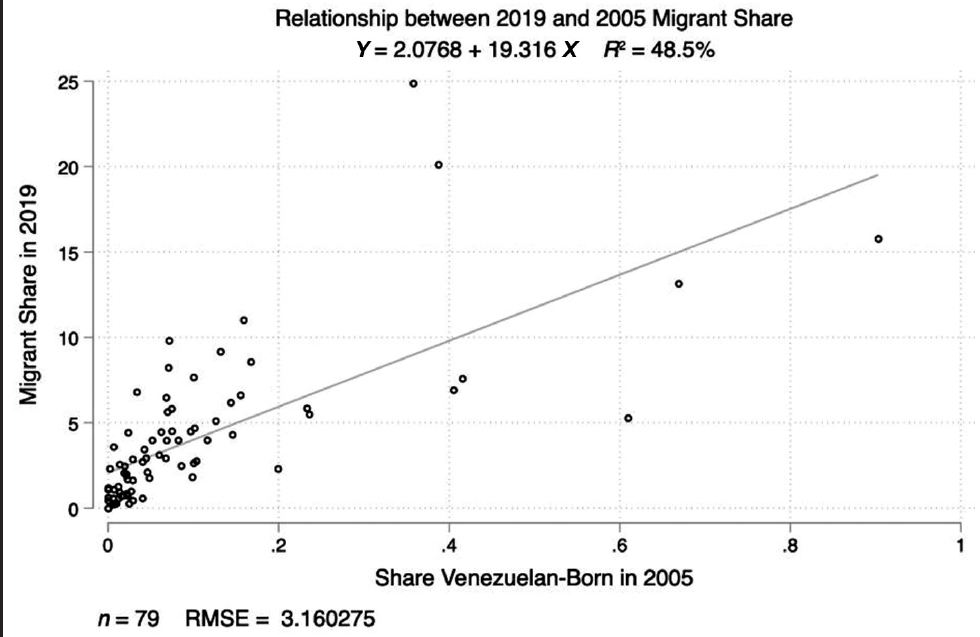
Note : RMSE, root mean square